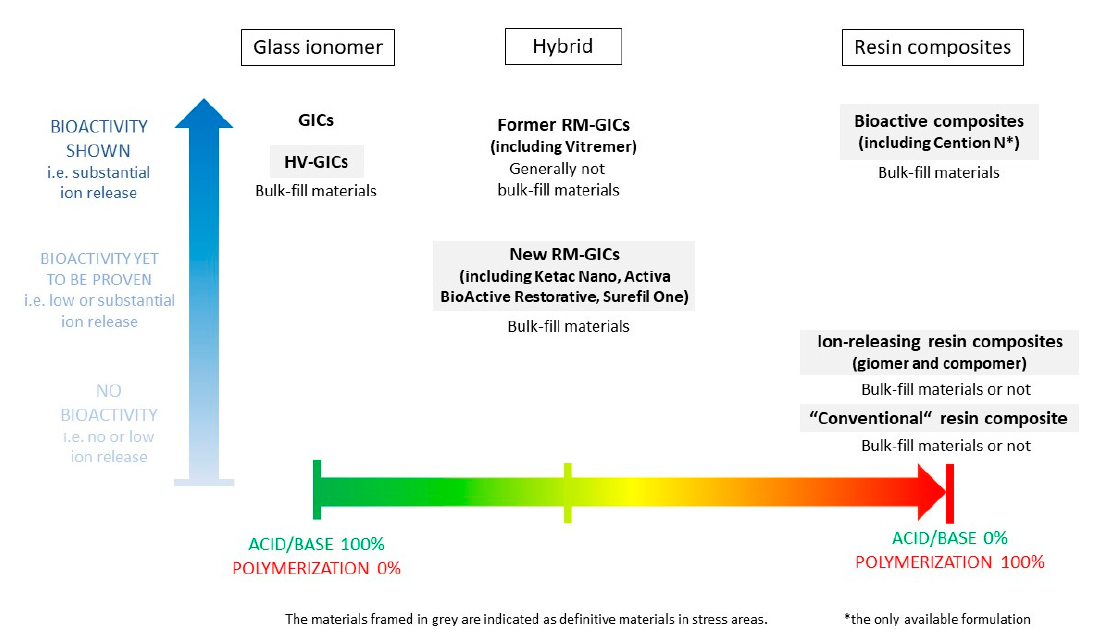
Figure 21. Classification of the fluoride-releasing materials according to: the importance of the acid/base reaction or resin polymerization in their setting, their bioactivity, their bulk-fill properties, and their bioactivity.